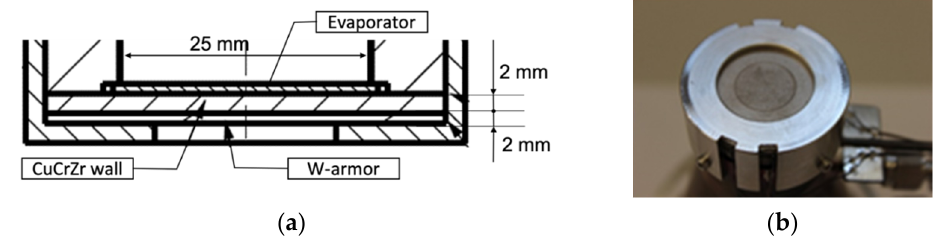
Figure 2. Depiction of HPEE. ( a ) Depiction with dimensions of HPEE evaporator-end with W-plate; ( b ) top view of the evaporator surface with W-plate and protective